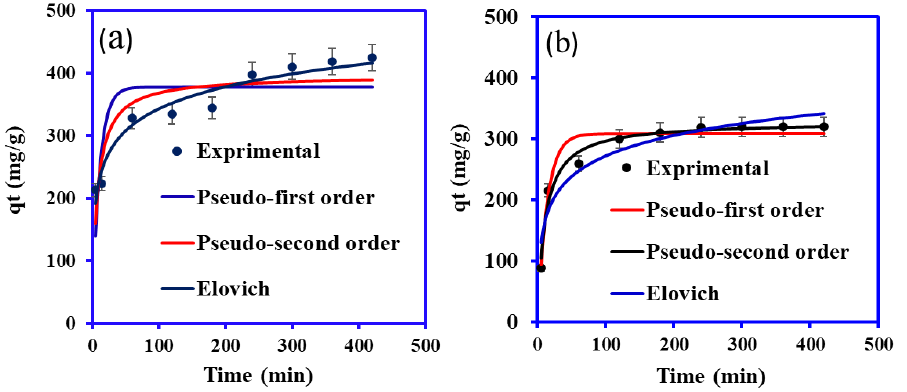
Figure 6. The kinetic plots for the adsorption of ( a ) Cu(II) and ( b ) phenol onto the PANI@WTP nano- composite (concentration, 500 mg/L; adsorbent dosage, 0.02g; volume, 20 mL; pH 5.2 for Cu(II), pH, nanocomposite (concentration, 500 mg/L; adsorbent dosage, 0.02 g; volume, 20 mL; pH 5.2 for Cu(II), 5 for phenol; temp, 30 °C). pH, 5 for phenol; temp, 30 ◦